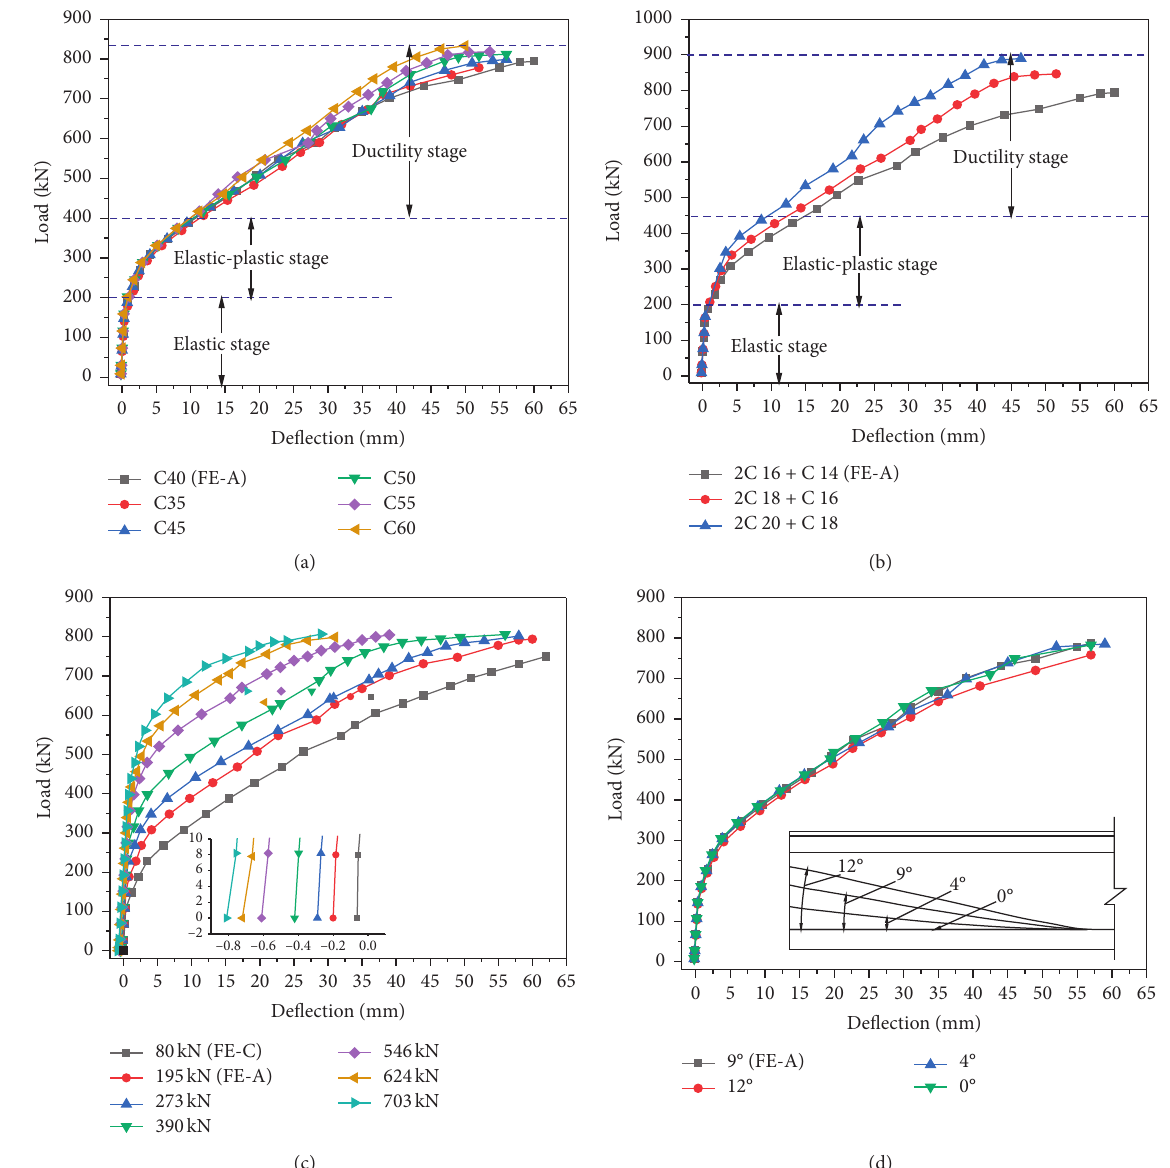
Figure 13: Load-deflection curves with single parameter. (a) Concrete strength. (b) Reinforcement ratio. (c) Prestress degree. (d) Bending